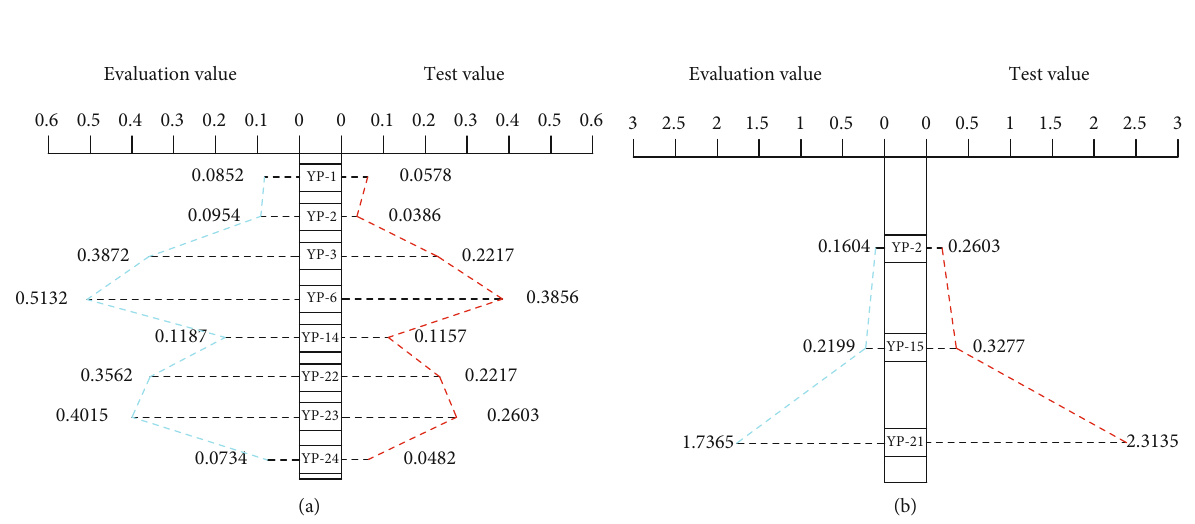
Figure 12: Comparative chart of theoretical and actual speci fi c